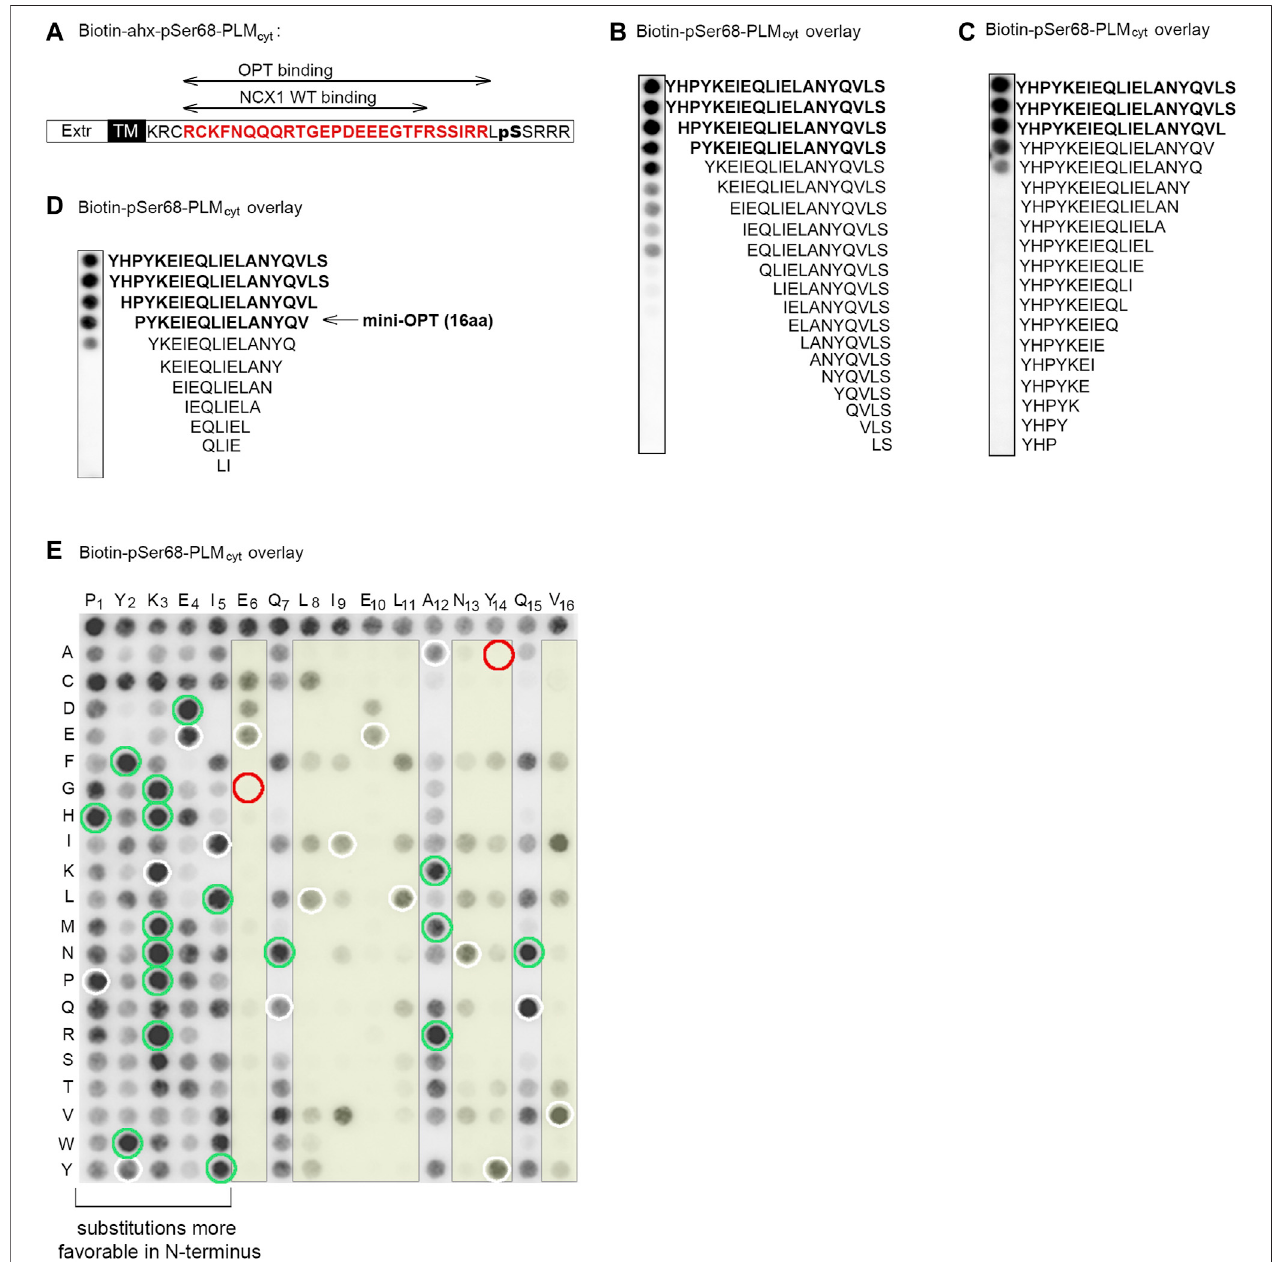
FIGURE 2 | Identi fi cation of the minimal PLM binding sequence in OPT and ofthe N-terminus as substitution tolerant. (A) Illustration of the NCX1 and OPT binding sequences in PLM and pSer68-PLM cytoplasmic parts (the latter in red) (Wanichawan et al., 2016). (B) N-terminal, (C) C-terminal or (D) both N- and C- terminal truncations of the 20-mer OPT peptide (Wanichawan et al., 2016) were synthesized on membranes and overlaid with biotin-pSer68-PLM. Biotin-pSer68-PLM binding was detected with a monoclonal anti-biotin-HRP conjugated antibody. The minimal pSer68-PLM binding sequence was the 16-mer PYKEIEQLIELANYQV (mini- OPT) asindicated in (D) . (E) Amino acidsubstitutionsofmini-OPTby two-dimensionalpeptidearrays aimed toidentify modi fi able positions. Biotin-pSer68-PLM binding wasdetectedwithamonoclonalanti-biotin-HRPconjugatedantibody.Eachresidueinthemini-OPTsequenceiswrittenasasingle-lettercodeabovethearray,whereas substitutions are given as single-letter codes to the left (vertically). The fi rst row of the array shows biotin-pSer68-PLM binding to mini-OPT ( n (cid:2) 16). White circles show biotin-pSer68-PLM binding to mini-OPT dispersed through the array (internal control peptides, n (cid:2) 16). Thus, in total, 32 spots showed biotin-pSer68-PLM binding to mini-OPT. Green circles indicate 17 substitutions that apparently enhanced peptide binding to biotin-pSer68-PLM. The E6G and Y14A substitutions (red circles) abolishedpSer68-PLMbindingandwereusedasnegativecontrolpeptidesinthepulldownexperimentin Figure3C .Theyellowboxesindicatepositionsthatwereless substitution tolerant than the